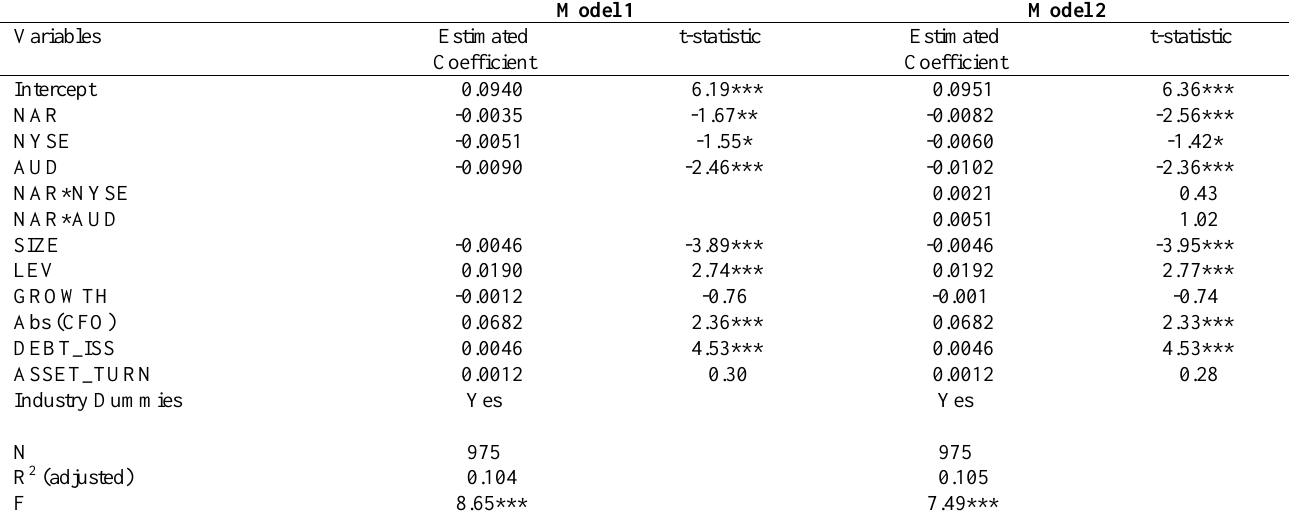
Table 7: Regressions of absolute discretionary accruals on independent variables and control